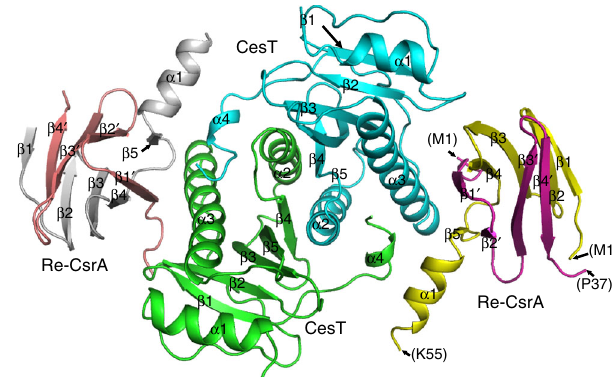
Fig. 2 The overall structure of the CesT/Re-CsrA complex. Two Re-CsrA molecules symmetrically bind to the CesT dimer. The secondary structure elements are labeled. In Re-CsrA, the prime symbols indicate the elements of the CsrA-C del moiety. The terminal residues of the CsrA-C del and the full-length CsrA moieties are marked with letters in